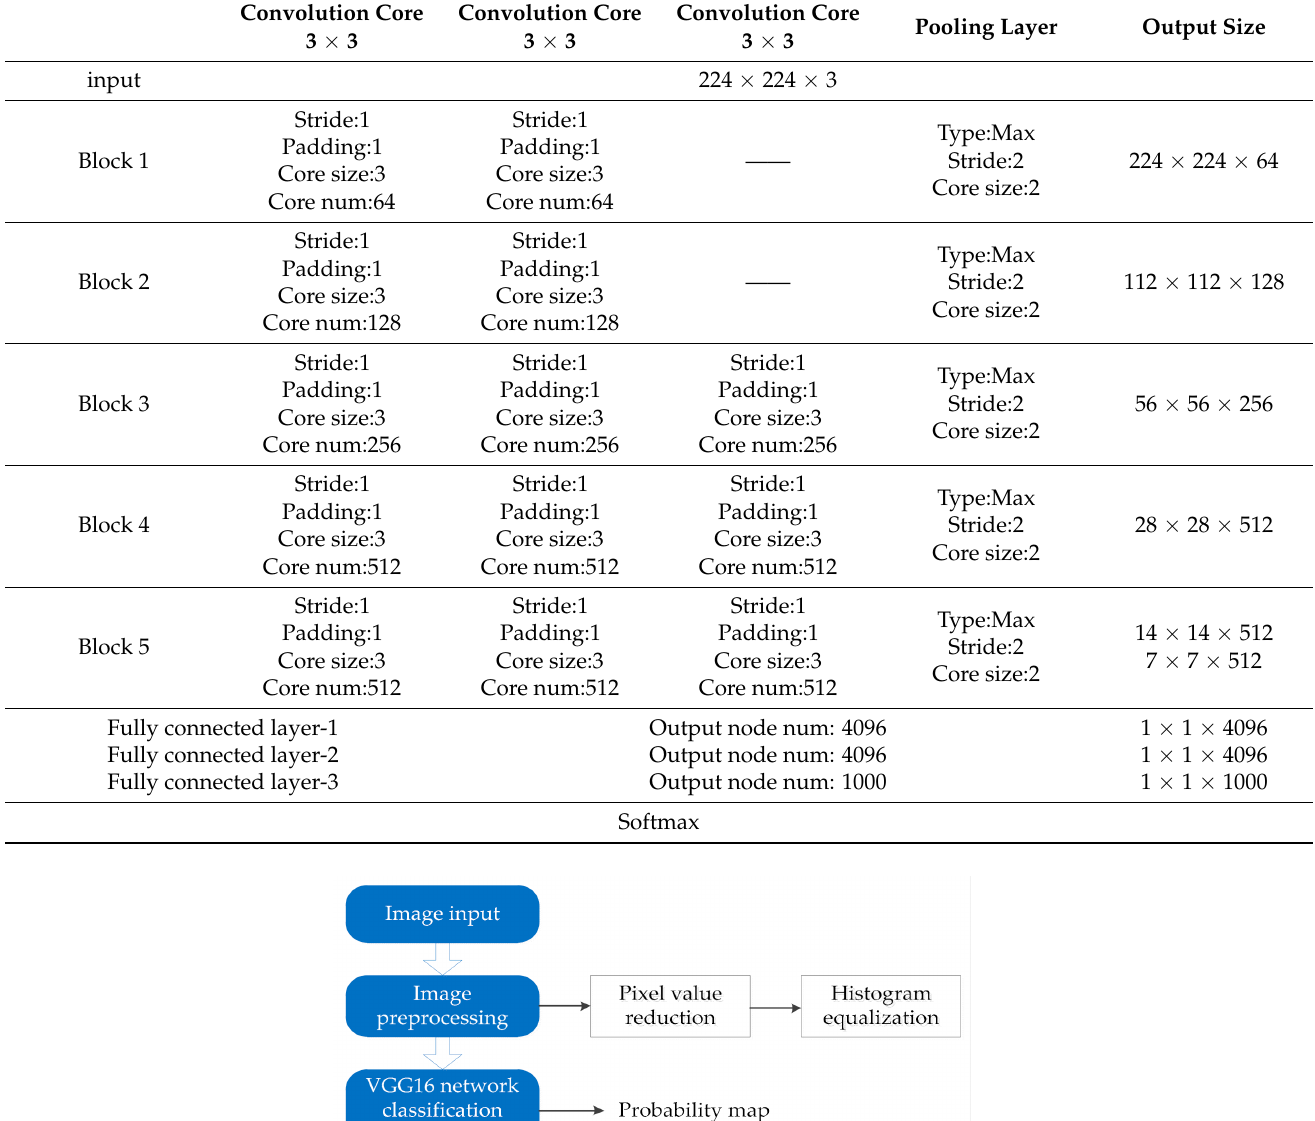
Table 1. Parameter configuration of VGG16 network model.